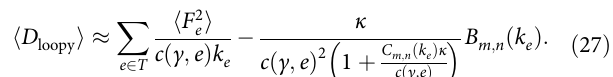
(cid:8) B ð k Þ : ð 27 Þ m ; n e